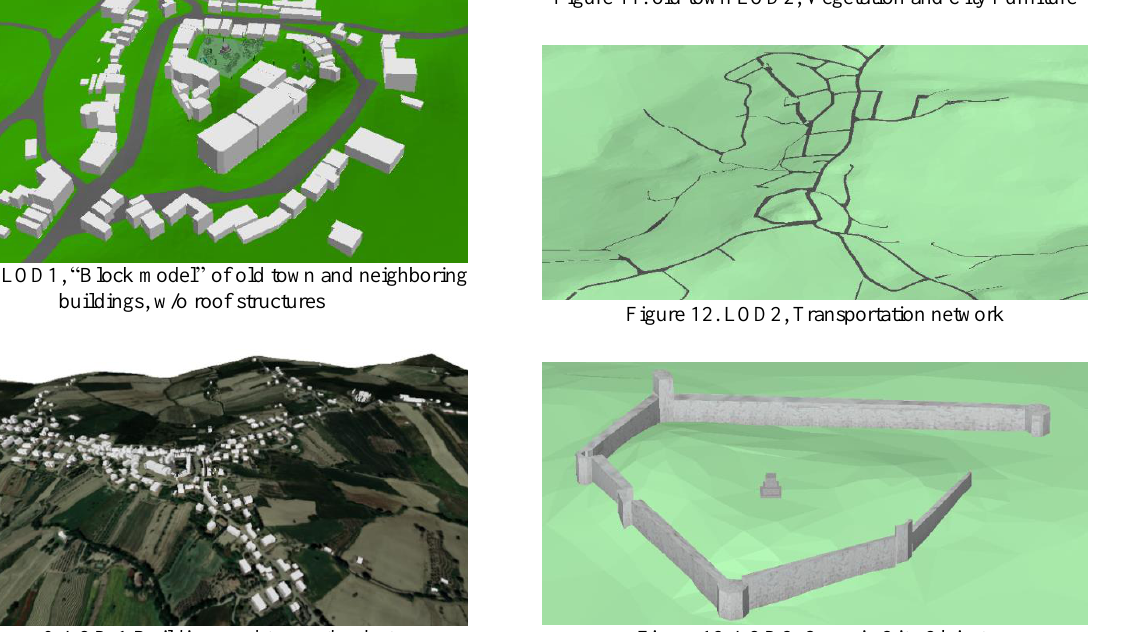
Figure 9. LOD 1 Buildings and true orthophoto